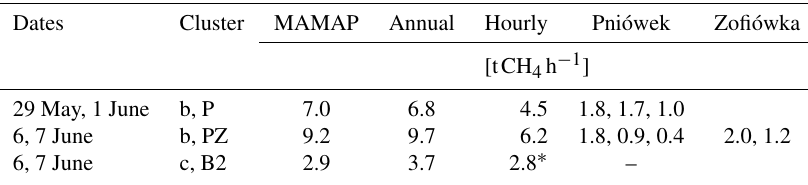
Table 3. Comparison of observed averaged fluxes based on MAMAP data with annually reported emissions and measured averaged hourly emissions, when available. The measured averaged hourly emissions are additionally split into the contributions of the three shafts for Pniówek and two shafts for Zofiówka. See also the main text for further